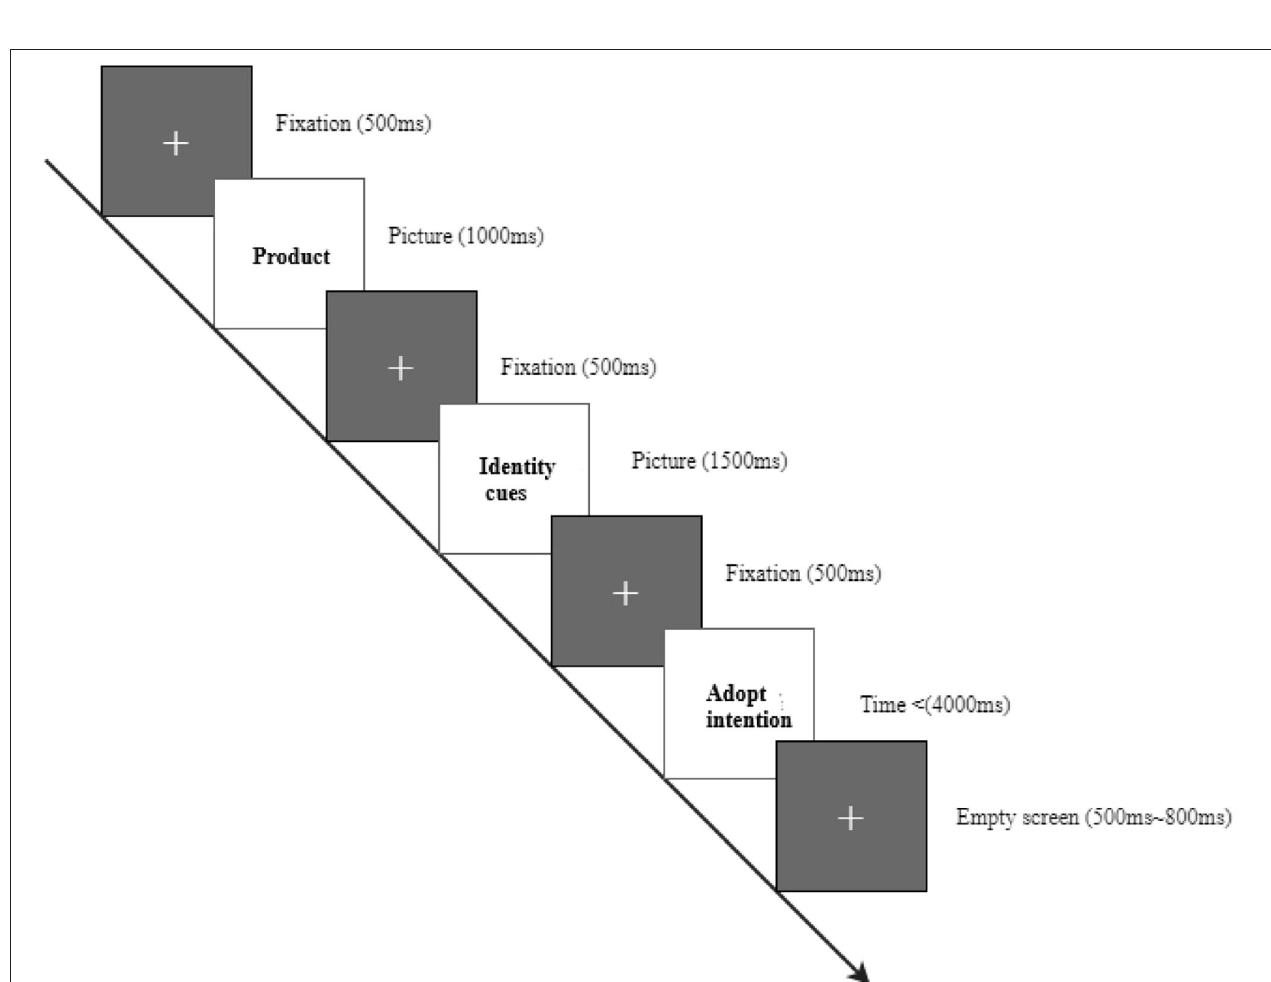
FIGURE 4 | The trial sequence (Subjects are instructed to choose their intentions to adopt the review according to the different identity cues).